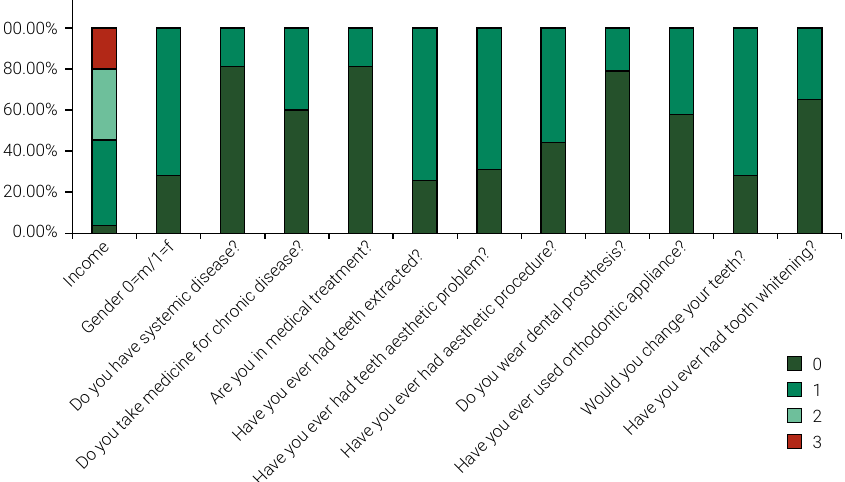
Figure 1. Sample characterization considering income, gender, general health and dental health conditions obtained by